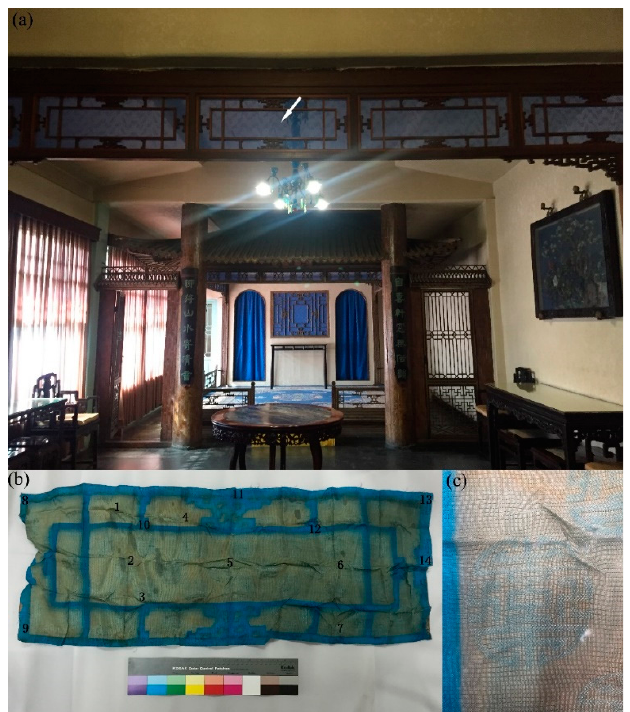
Figure 1. ( a ) Marquisette curtain in the Studio of Cleansing Fragrance (arrow points to its original location); ( b ) the original appearance, including a micro-analysis marked with numbers 1–14; and ( c ) the amplified traditional auspicious and longevity decorated pattern.